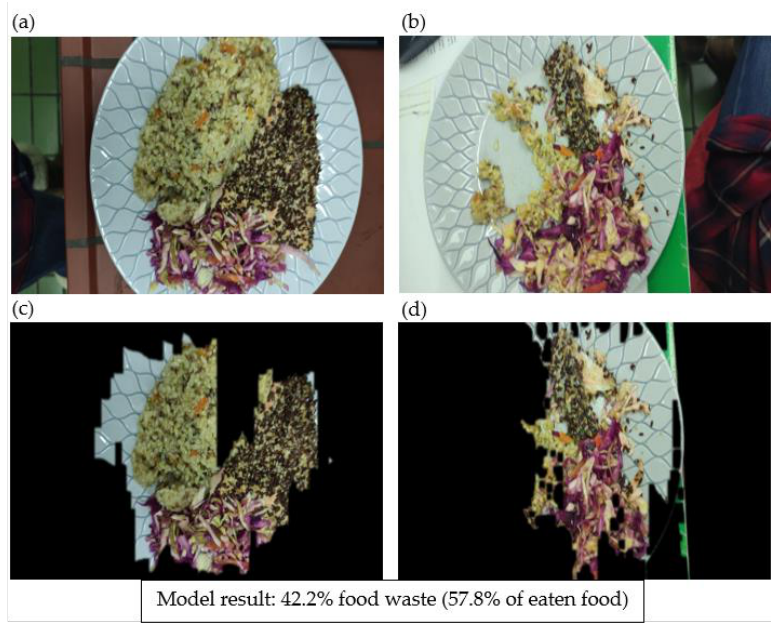
Figure 6. The model deficiency caused by the shape of the plate; ( a ) before the meal, ( b ) after the meal, ( c ) before the meal and masked and ( d ) after the meal and masked.